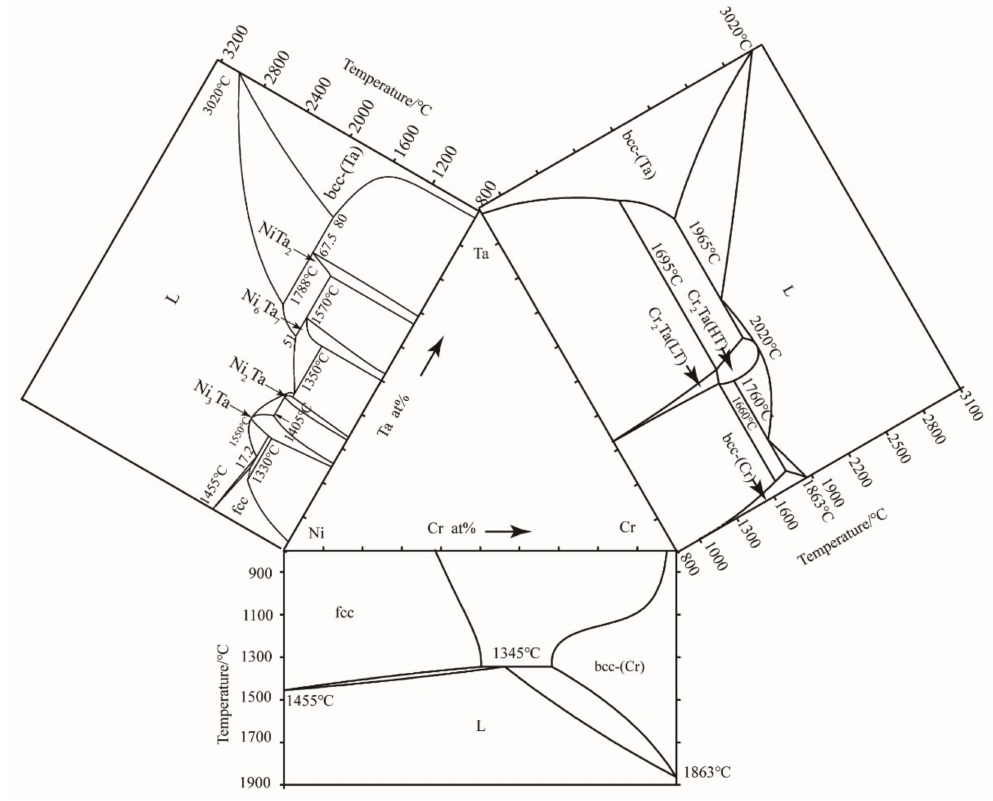
Figure 1. Binary phase diagrams constituting the Ni-Cr-Ta ternary system